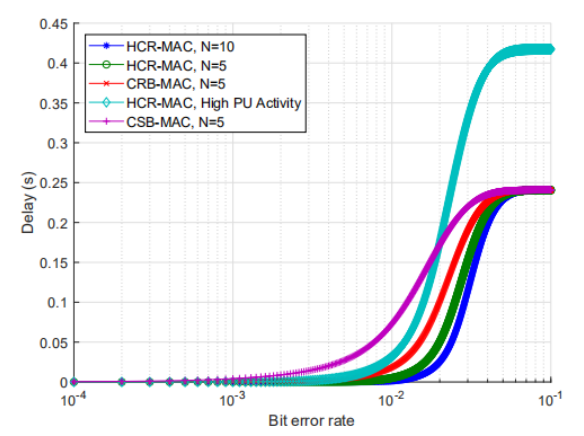
Figure 5. Delay performance against